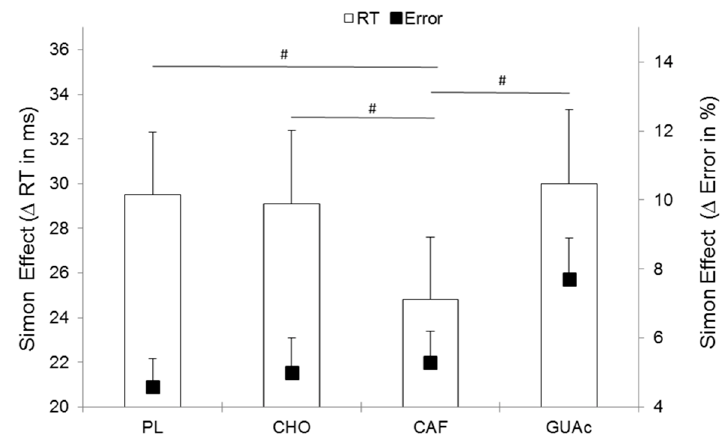
Figure 4. Simon Effect for reaction time (RT) and error as a function of supplementation. Errors bars represent standard errors of the mean Δ . # 75–95% likely different.